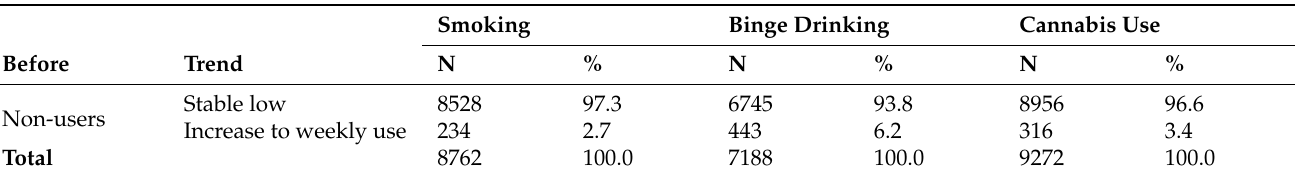
Table 4. Overview of trends in substance use during the first COVID-19 lockdown in non-users and weekly users before